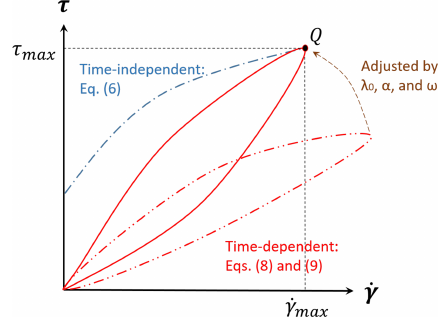
Figure 1. Concept of a graphical method B for estimating a consis- tent set of λ 0 ,α,andω parameters for the Coussot